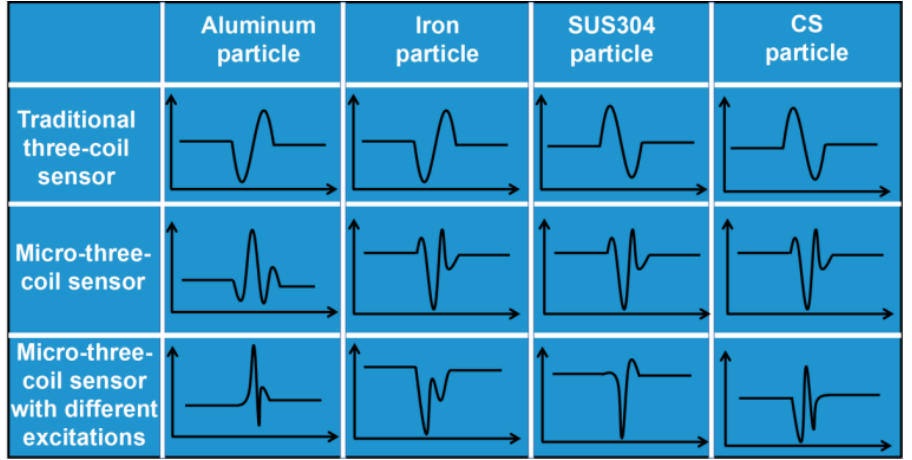
Figure 11. Detection method and signal.